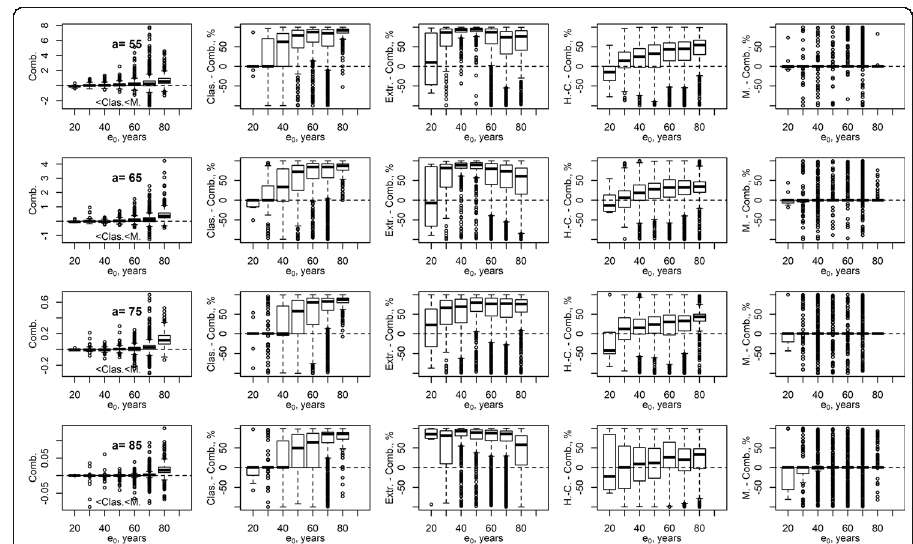
Fig. 3 Boxplots of estimation errors in life expectancy at birth obtained by the combination (7) of the classical and Mitra methods (the combined method, “ Comb. ” ) at selected starting ages a of the open age interval (plots in the first column). Plots in the last four columns: boxplots, as a function of life expectancy at birth, of percentage differences of absolute errors (5) of the combined method and single methods as indicated at the vertical axes. Female populations. Methods covered: the classical method ( “ Clas. ” ), extrapolation method based on 20-years-long age base ( “ Extr. ” ), Horiuchi-Coale method ( “ H.-C. ” ), and Mitra method ( “ M ”